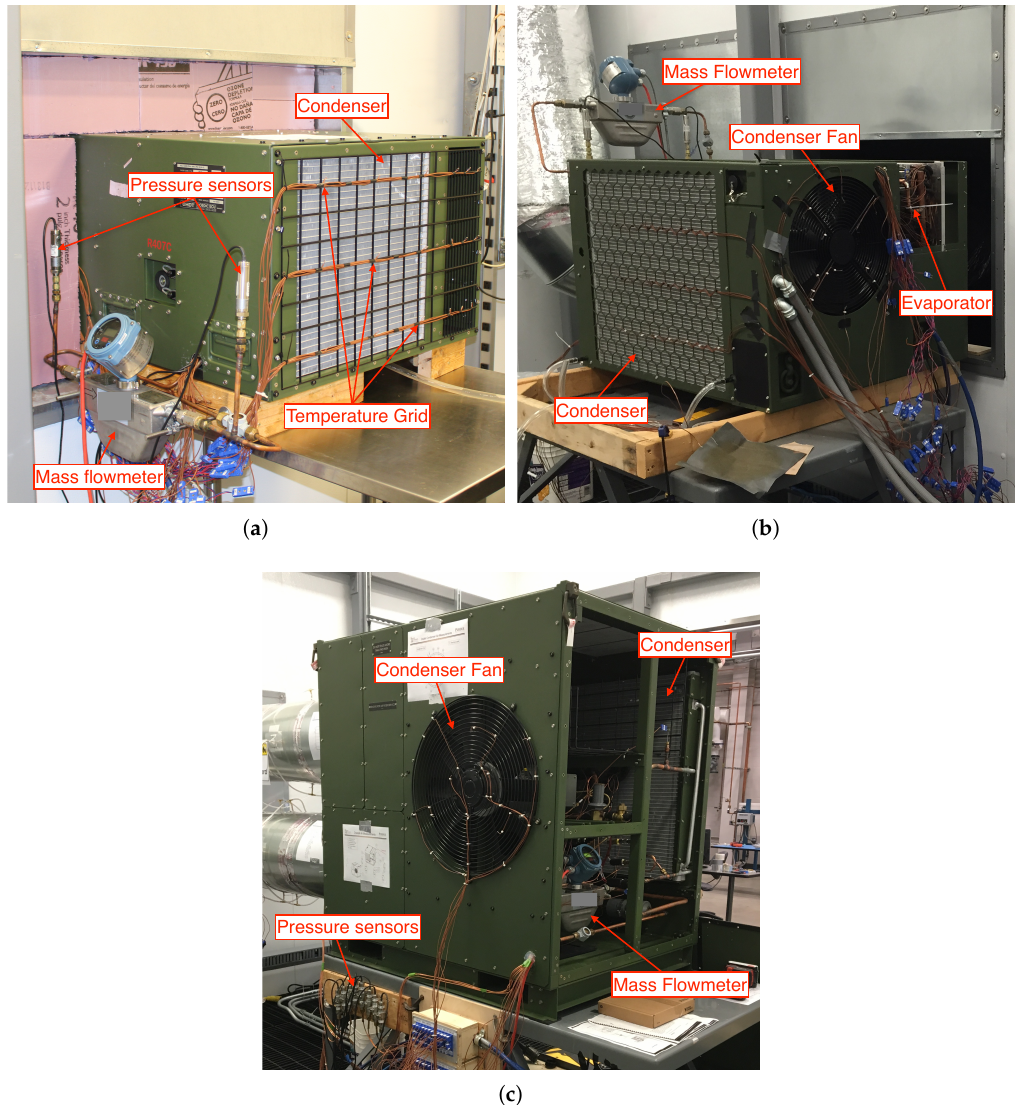
Figure 2. Physical layout of ( a ) 1.5-RT, ( b ) 3-RT, and ( c ) 5-RT ECUs with the installed measurement instruments for experimental testing at the psychrometric